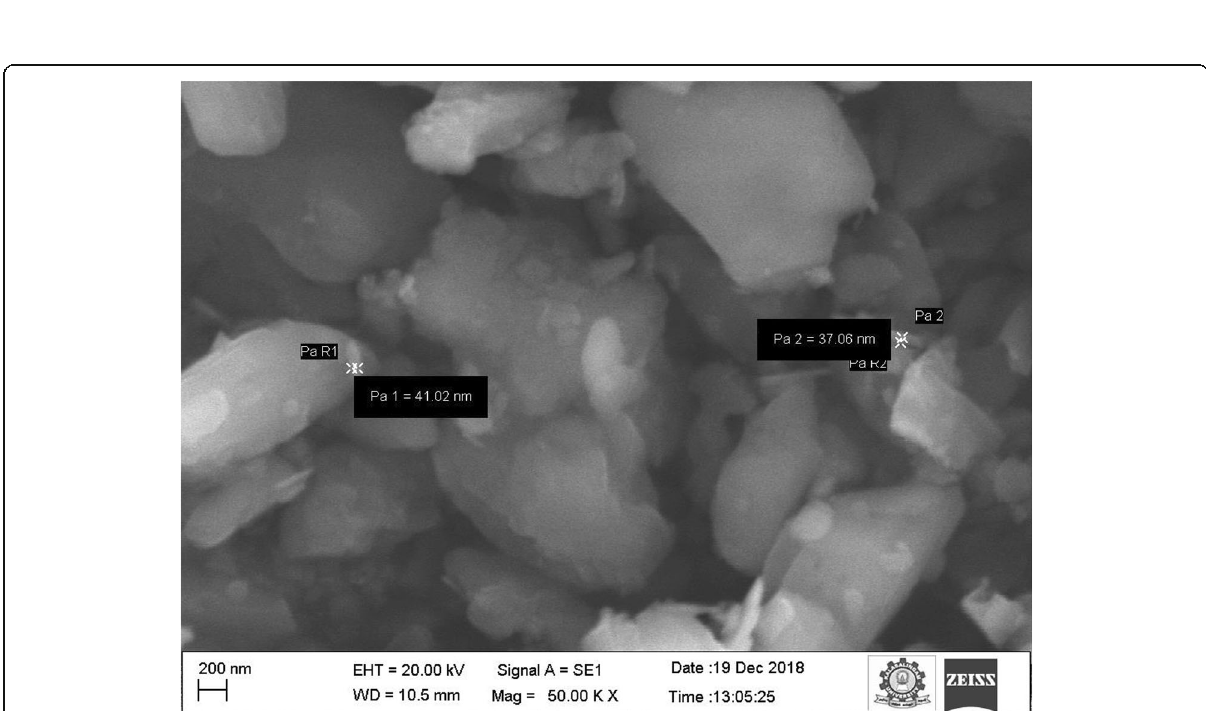
Fig. 10 SEM micrograph of 50 mg A. marmelos added CHPD